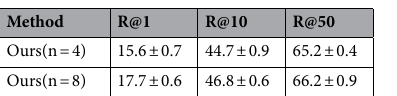
Table 5. Ablation studies of Transformer layers on Fashion200k dataset.